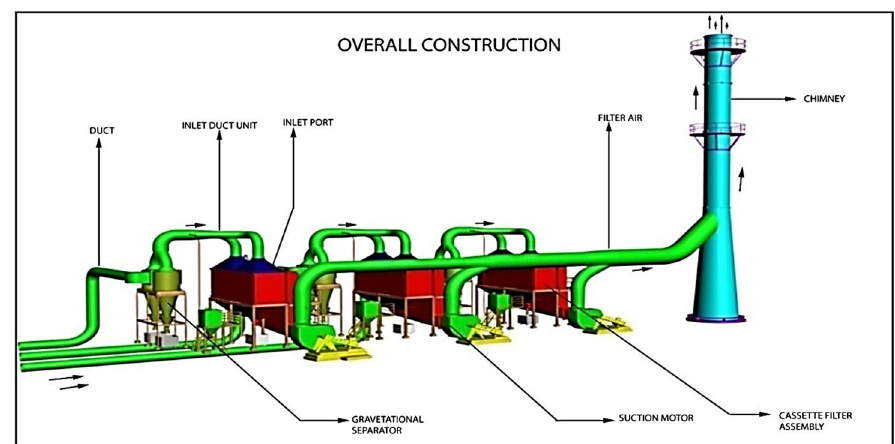
Fig 2. Schematic layout of cartridge type filter assembly.